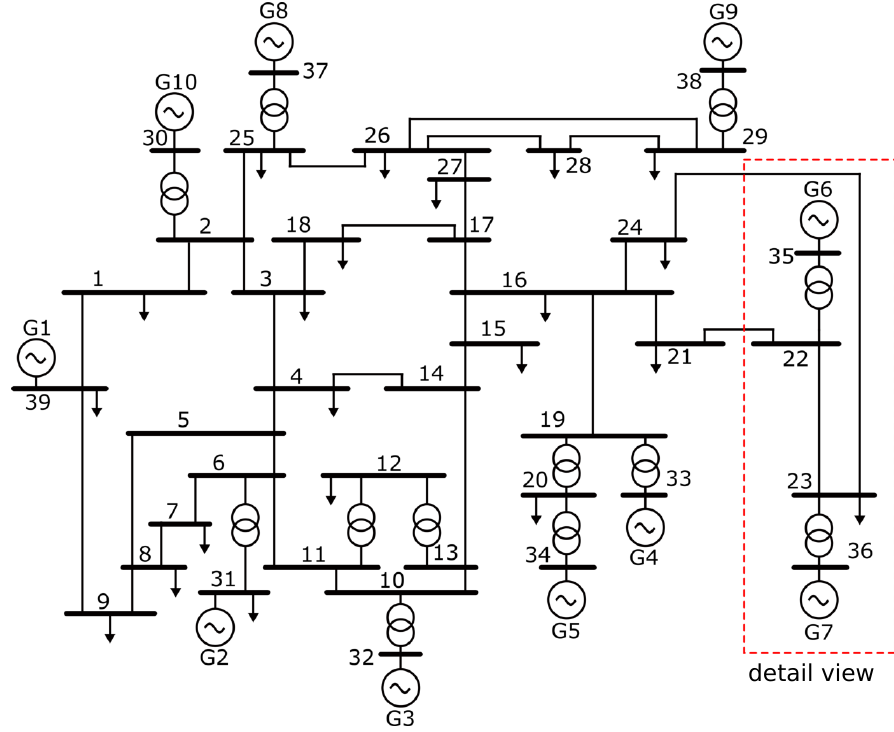
Figure 2. A single-line diagram of the IEEE New England 39-bus test case power